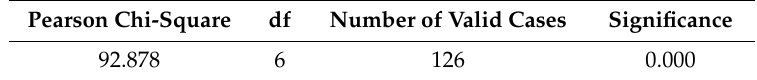
Table 2. Pearson chi-square test.